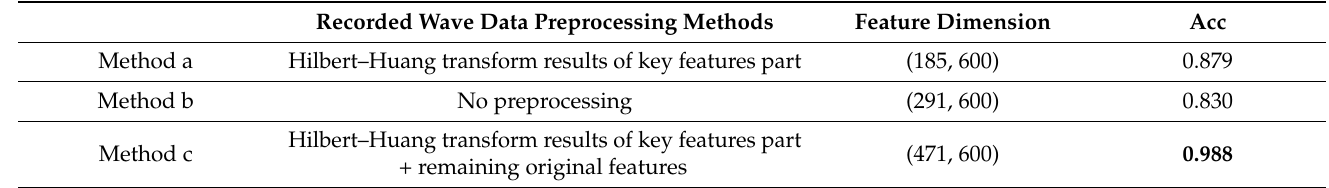
Table 4. Comparison of the identification effects of the hybrid model trained on the recorded wave data obtained by the three preprocessing methods.